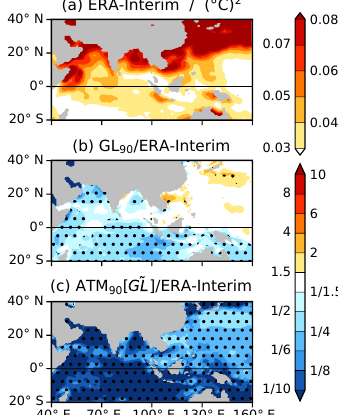
Figure 7. (a) Variance of 24–70-day bandpass-filtered ERA-Interim SST for May to October only. Ratio to ERA-Interim of (b) GL 90 , (c) ATM 90 [ f GL]; stippling indicates 95% statistical significance ac- cording to a two-tailed f